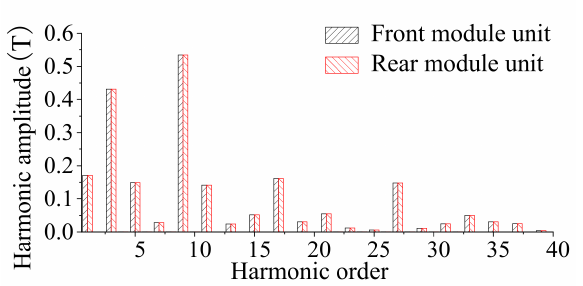
Figure 6. PM flux density harmonic distribution for AMA-FRPM